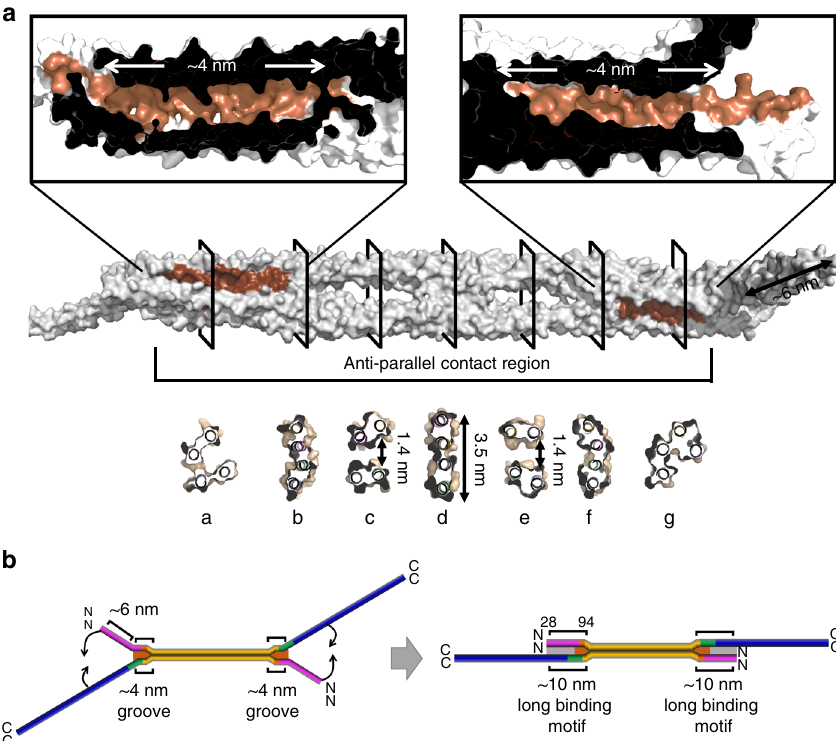
Fig. 6 The grooves and the space in the lamin A11 tetramer. a The lamin tetramer is shown in the surface representation (grey), and the anti-parallel contact region is marked. Two ~4-nm-long grooves are in brown and enlarged in the top panel. The cross-sections, marked with a – g, are shown in the bottom panel. b The bent model of the full-length rod domain re fl ecting the crystal structure of the lamin A11 tetramer is shown in the left panel and the straightened model is shown in the right panel. The sub-domains are coloured differently as shown in Fig. 1a. The ~4 nm grooves and ~6-nm-long spaces are in brown and light grey, respectively. Detailed information for the model construction is depicted in Supplementary Fig.